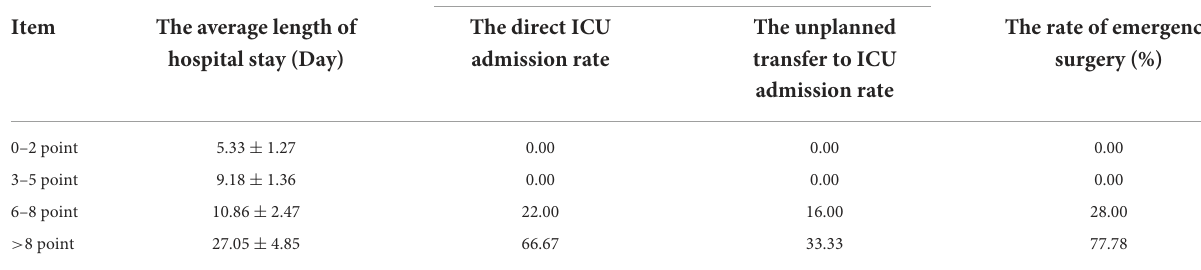
TABLE 5 Comparison results of different MEWS score